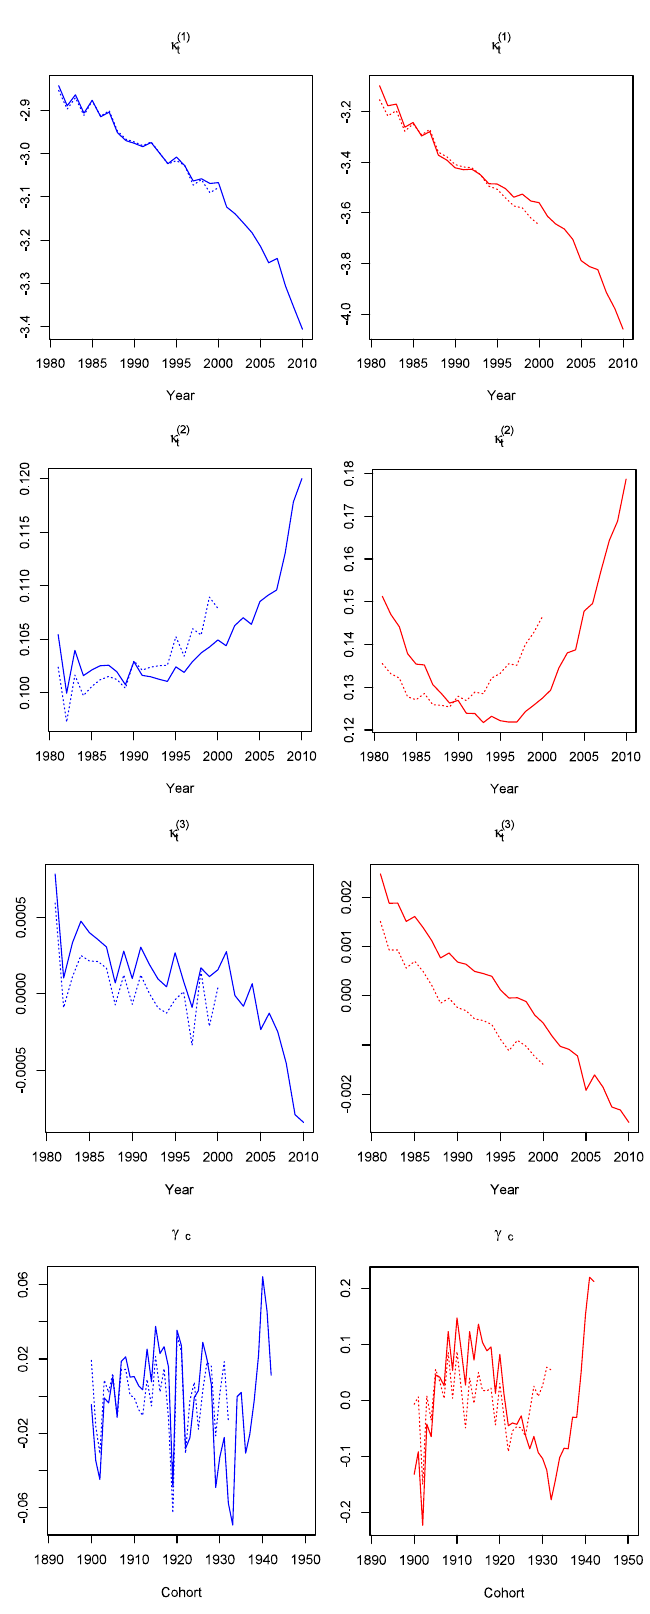
( 1 ) ( 2 ) ( 3 ) Figure 7. M 7 : κ , κ , κ and γ c estimated parameters for males ( left panels) and females ( right t t t panels), aged 60–89, fitted in 1981–2010 (solid lines) and 1981–2000 (dotted